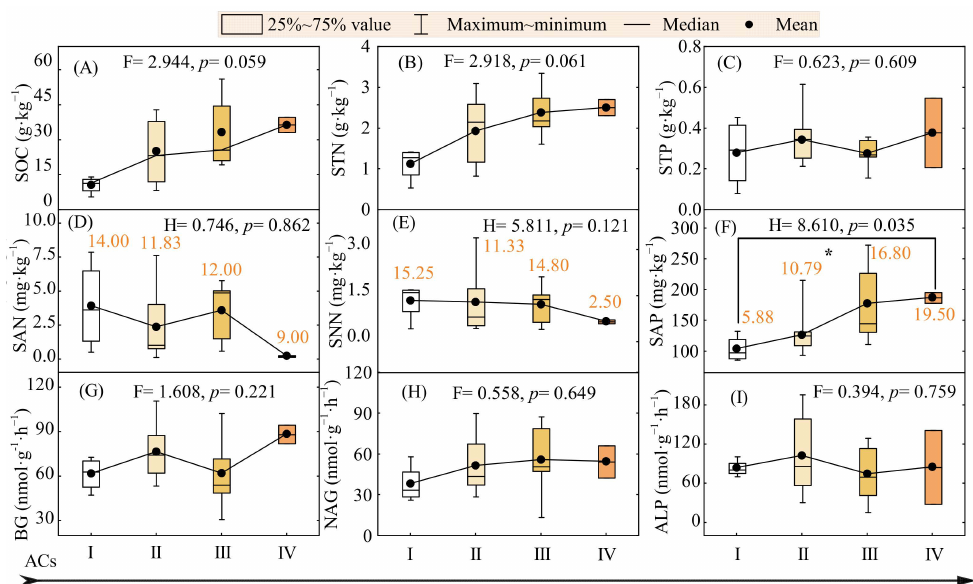
Figure 3. Characteristics of soil nutrient concentrations ( A – F ) and extracellular enzymatic activity ( G – I ) changed with ACs in the surface soil. (*) indicate the significant difference between different ACs. The brown-red letters represent mean ranks of each AC in subfigures ( D – F ), which were calculated using the Kruskal–Wallis rank test. The differences among four ACs in other subfigures were examined by the LSD